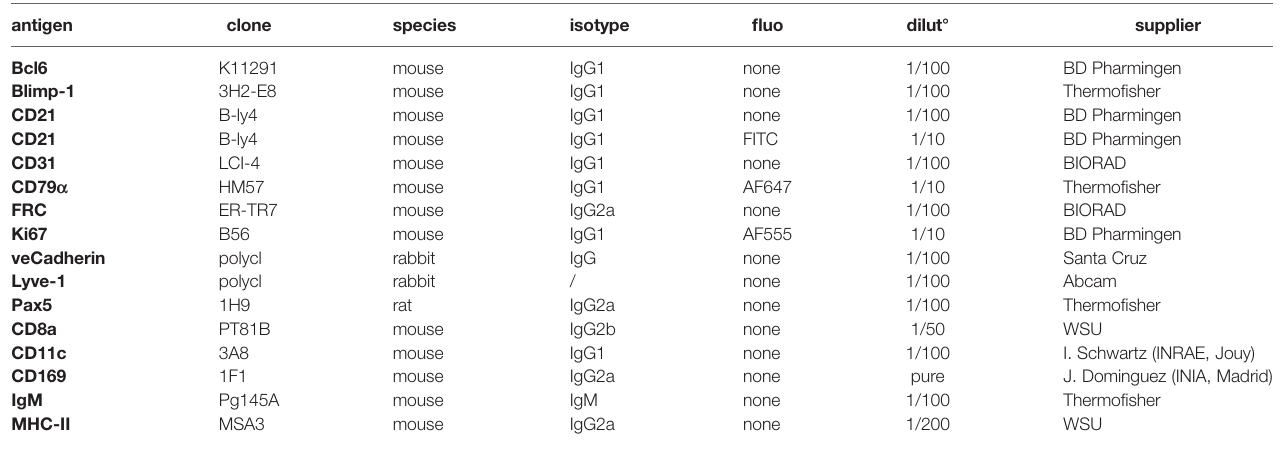
TABLE 1 | Antibodies